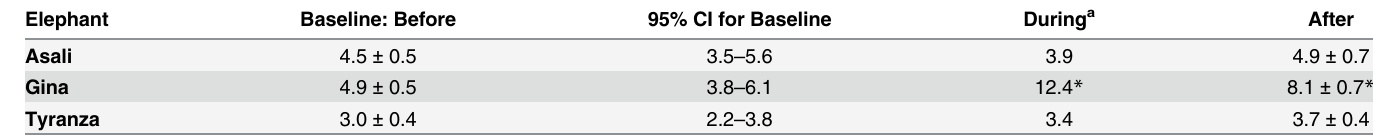
Table 3. Mean ± standard error (SE) of serum cortisol (ng/ml) across periods of renovation in the elephant house. Elephant